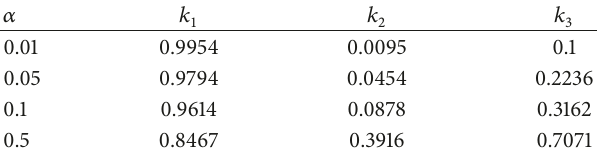
Table 1: Optimal control gains with different weight.